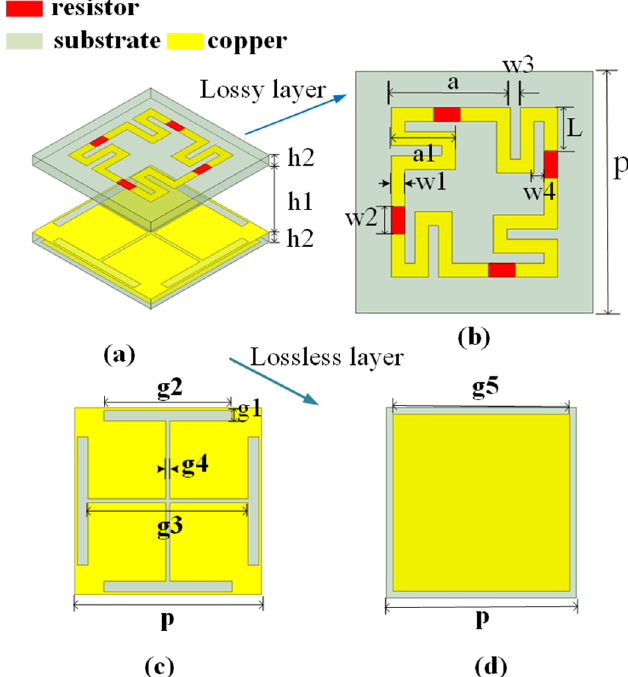
Fig. 1. Topology and dimensions of proposed FSR. (a) Three- dimensional structure diagram of proposed FSR. (b) Lossy layer. (c) Upper surface structure of lossless layer: Jerusalem cross. (d) Lower surface structure of lossless layer: Capacitive metal patch.